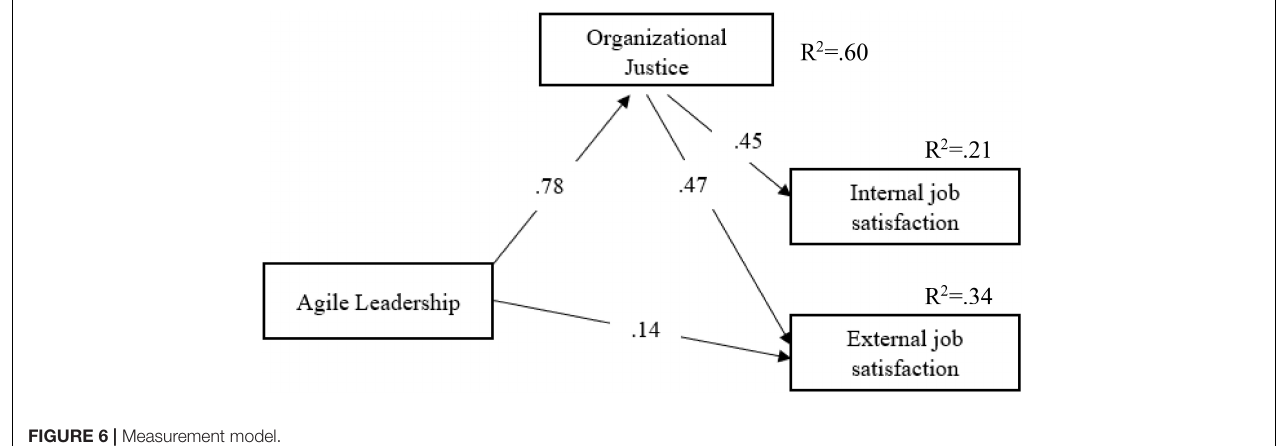
FIGURE 6 | Measurement model. TABLE 4 | Regression values between variables.